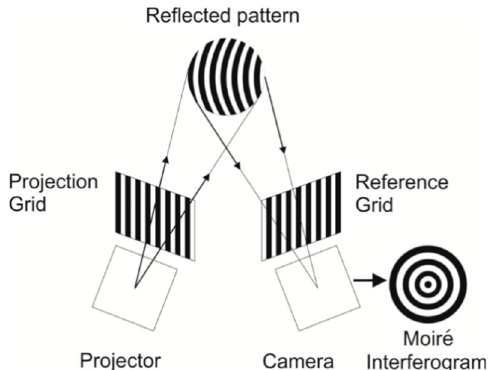
Figure 6. Schematic diagram of the projection Moiré profilometry [61].